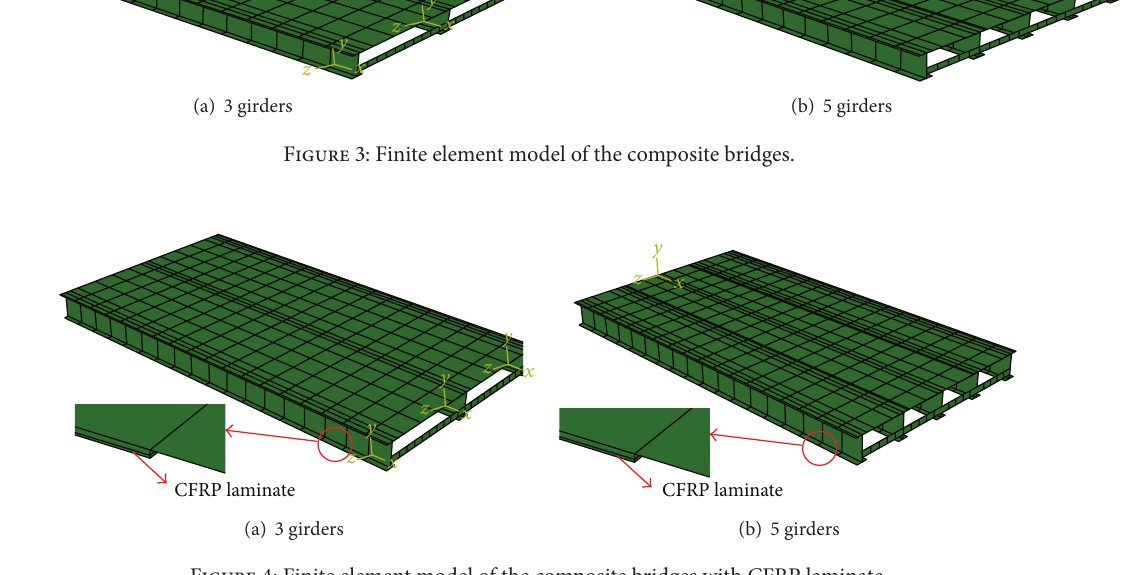
Figure 4: Finite element model of the composite bridges with CFRP laminate.